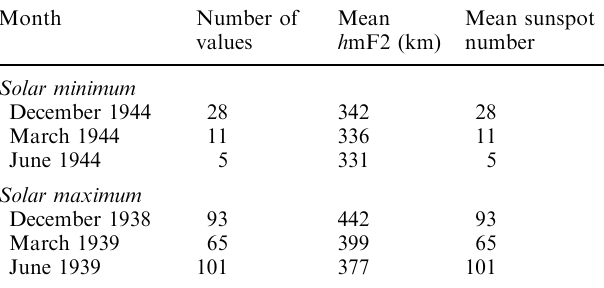
Table 1. Height of the F2 peak at Huancayo, computed from the data of Croom et al. (1959) Month Number of